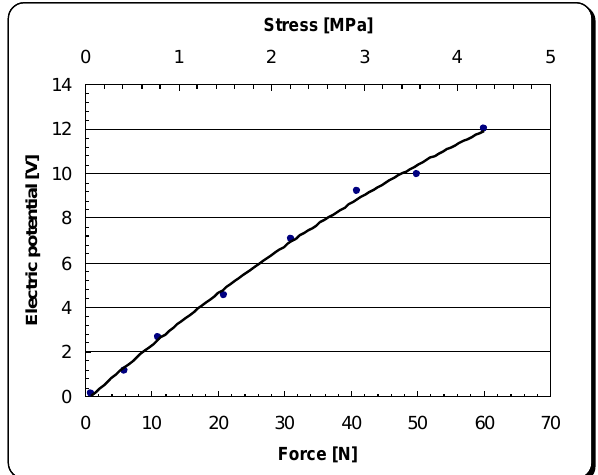
Figure 4. Force vs. open circuit electric potential curve of the DPT transducer [P-876 DuraAct™